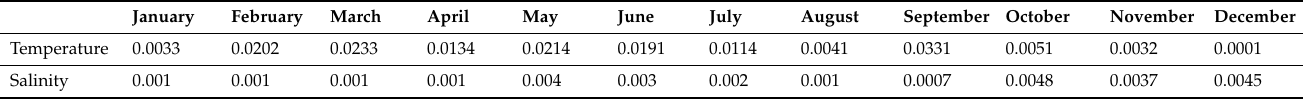
Table 1. NMAE estimation, comparing results of the RMA10 model and field measurements.